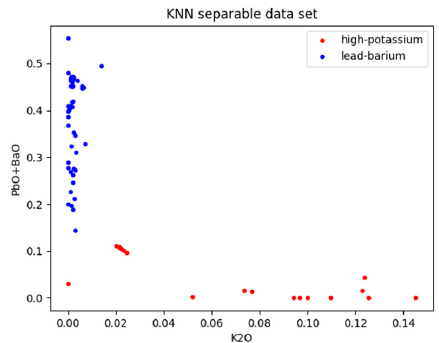
Figure 6. KNN classification results.